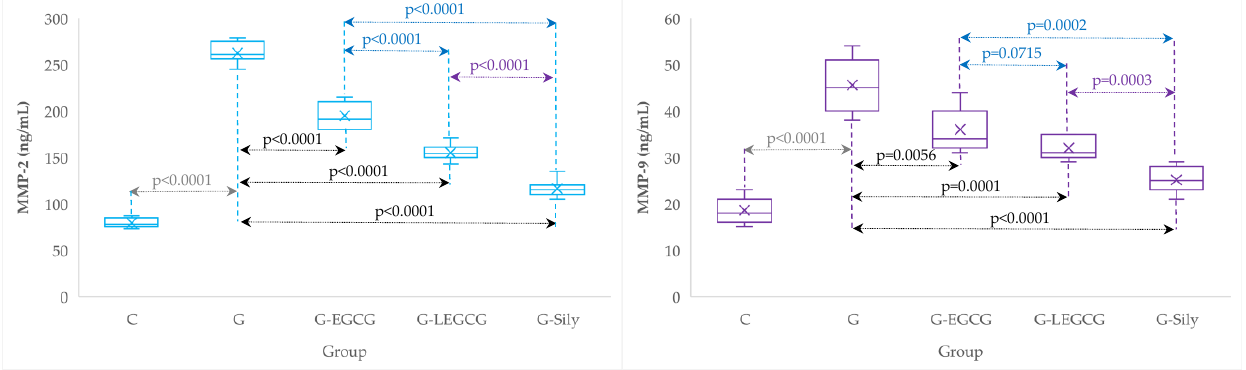
Figure 3. Serum levels of matrix metalloproteinases (MMP) 2 and 9 by groups. C, control group; G, gentamicin group; G-EGCG, gentamicin and epigallocatechin gallate group; G-LEGCG, gentamicin and liposomal epigallocatechin gallate group; G-Sily, gentamicin and silymarin